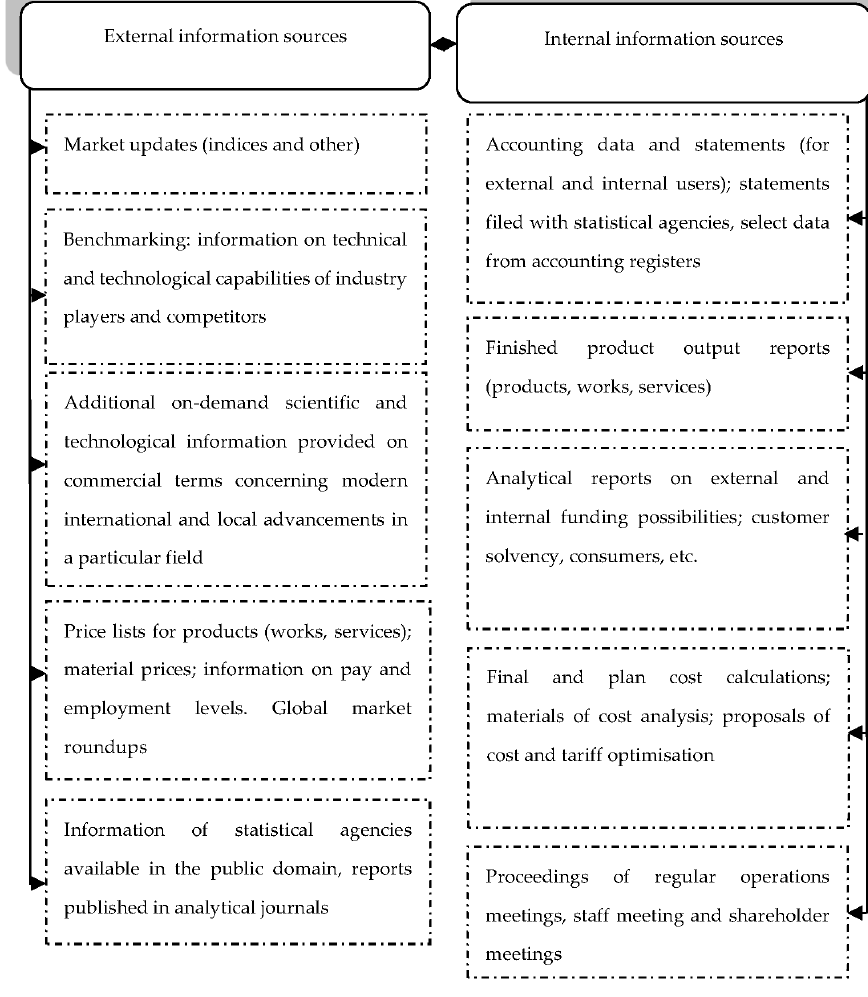
Figure 1. Information sources for CVP analysis (our